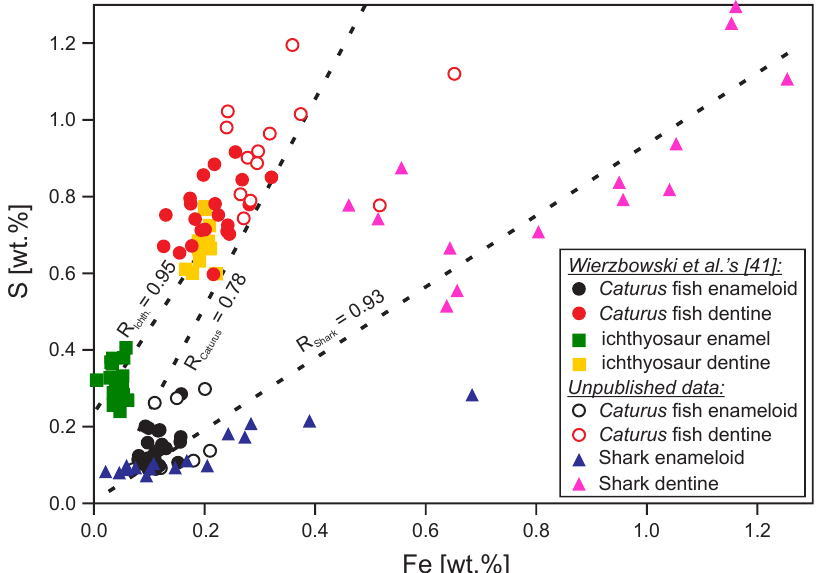
Figure 5. Fe and S concentrations in uppermost Jurassic Cryopterygius kielanae ichthyosaur and Caturus fish teeth from central Poland as well as Eocene Striatolamia shark teeth from Seymour Island (Antarctica). All measurements were conducted using an electron microprobe (Cameca SX100). Fe and S concentrations are relatively low in enamel(oid) and high in dentine. Diagenetic incorporation of both elements is revealed by strong, positive correlation of their concentrations; the linear relationships have slightly different slope in three groups in studied teeth (unpublished data and data from Wierzbowski et al.